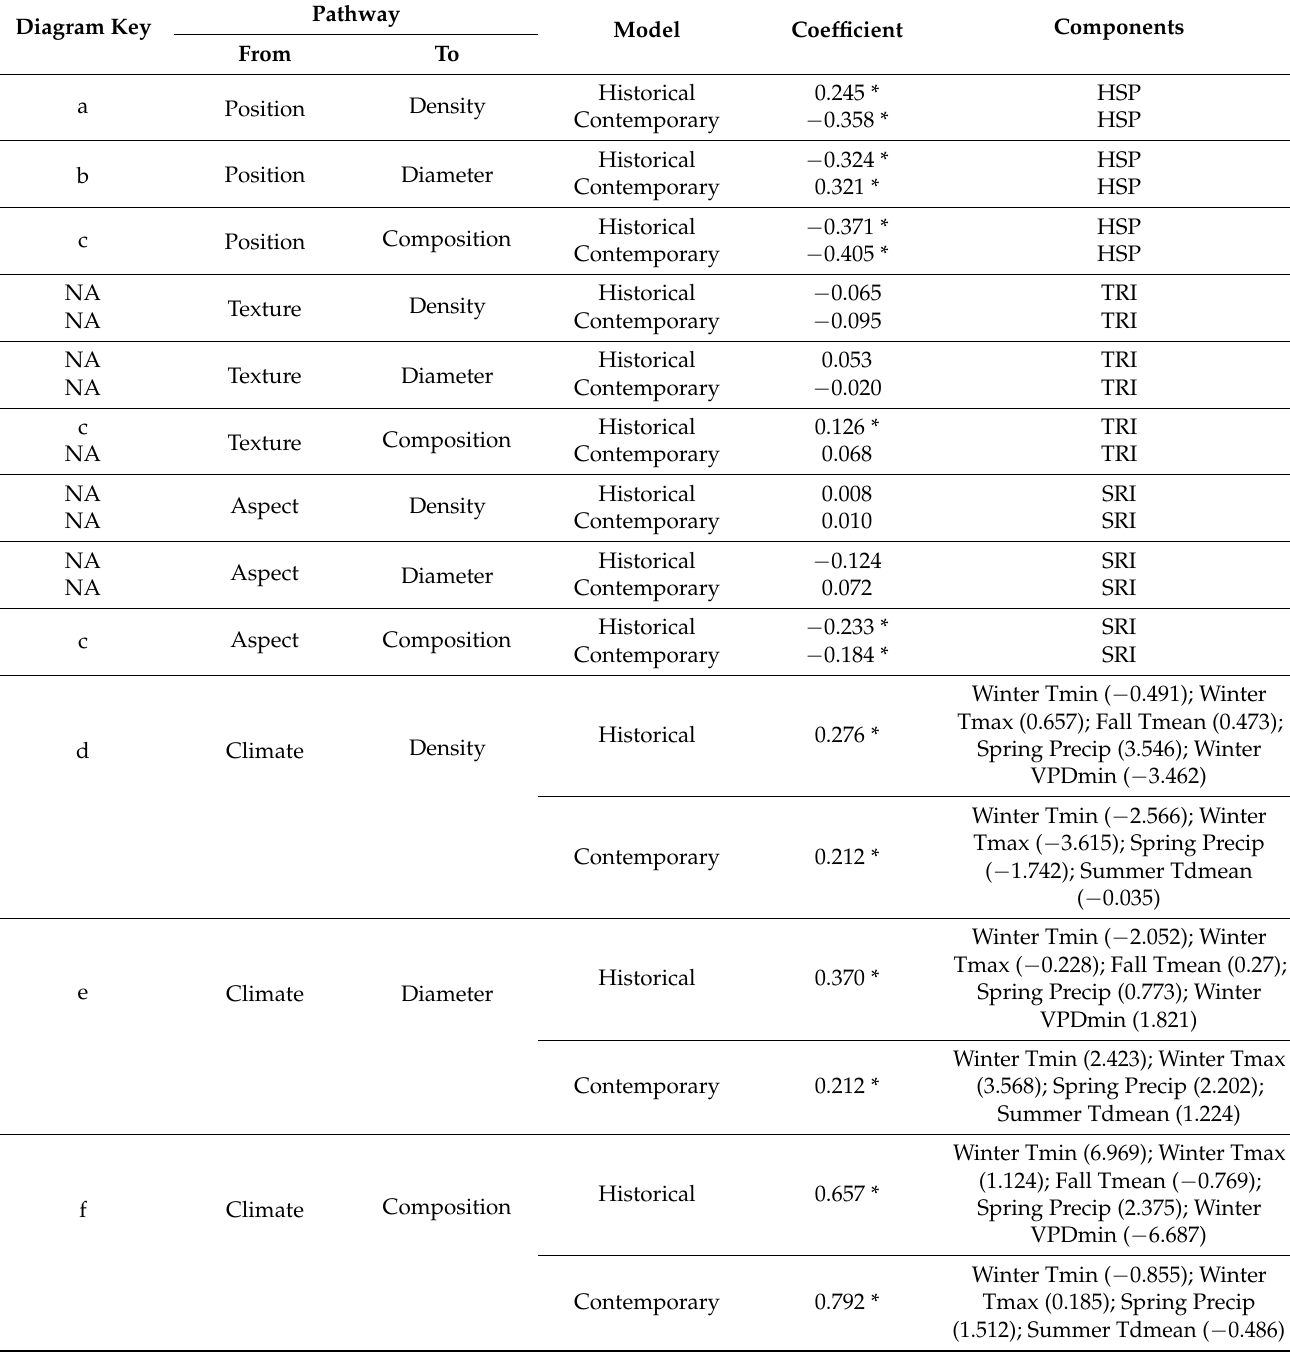
Table A2. Summary of pathways in historic and contemporary models. Letters in the Diagram Key column correspond to the letters on pathways in Figures 8 and 9. Values of NA indicate that this pathway is not included in these model diagrams. Pathway: From and Pathway: To describe the directional relationship between model components that each pathway represents. The Model column indicates whether the following values correspond to the pathway in the historical model or the Contemporary model. The Coefficient column contains the path coefficient, which describes the relative magnitude and direction of each pathway’s relationship. Values with * are statistically significant from 0 ( p < 0.05). The Components column contains the predictors used to calculate each pathway; if more than one predictor was used, the path coefficients used to calculate the composite are given in